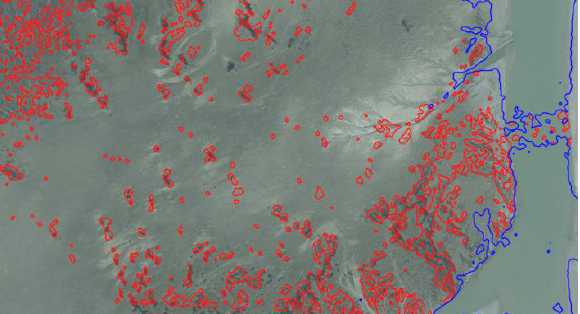
Figure 8. Orthoimage and the generated object classes for water (blue) and mussel bed